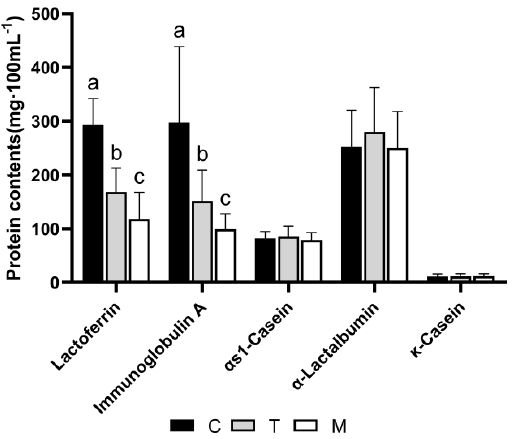
Figure 7. The concentrations of lactoferrin, immunoglobulin A, α s1 − casein, α − Lactalbumin, and κ− casein in three different lactation periods. Different letters represent significant differences in protein contents in different lactation periods ( p < 0.05).